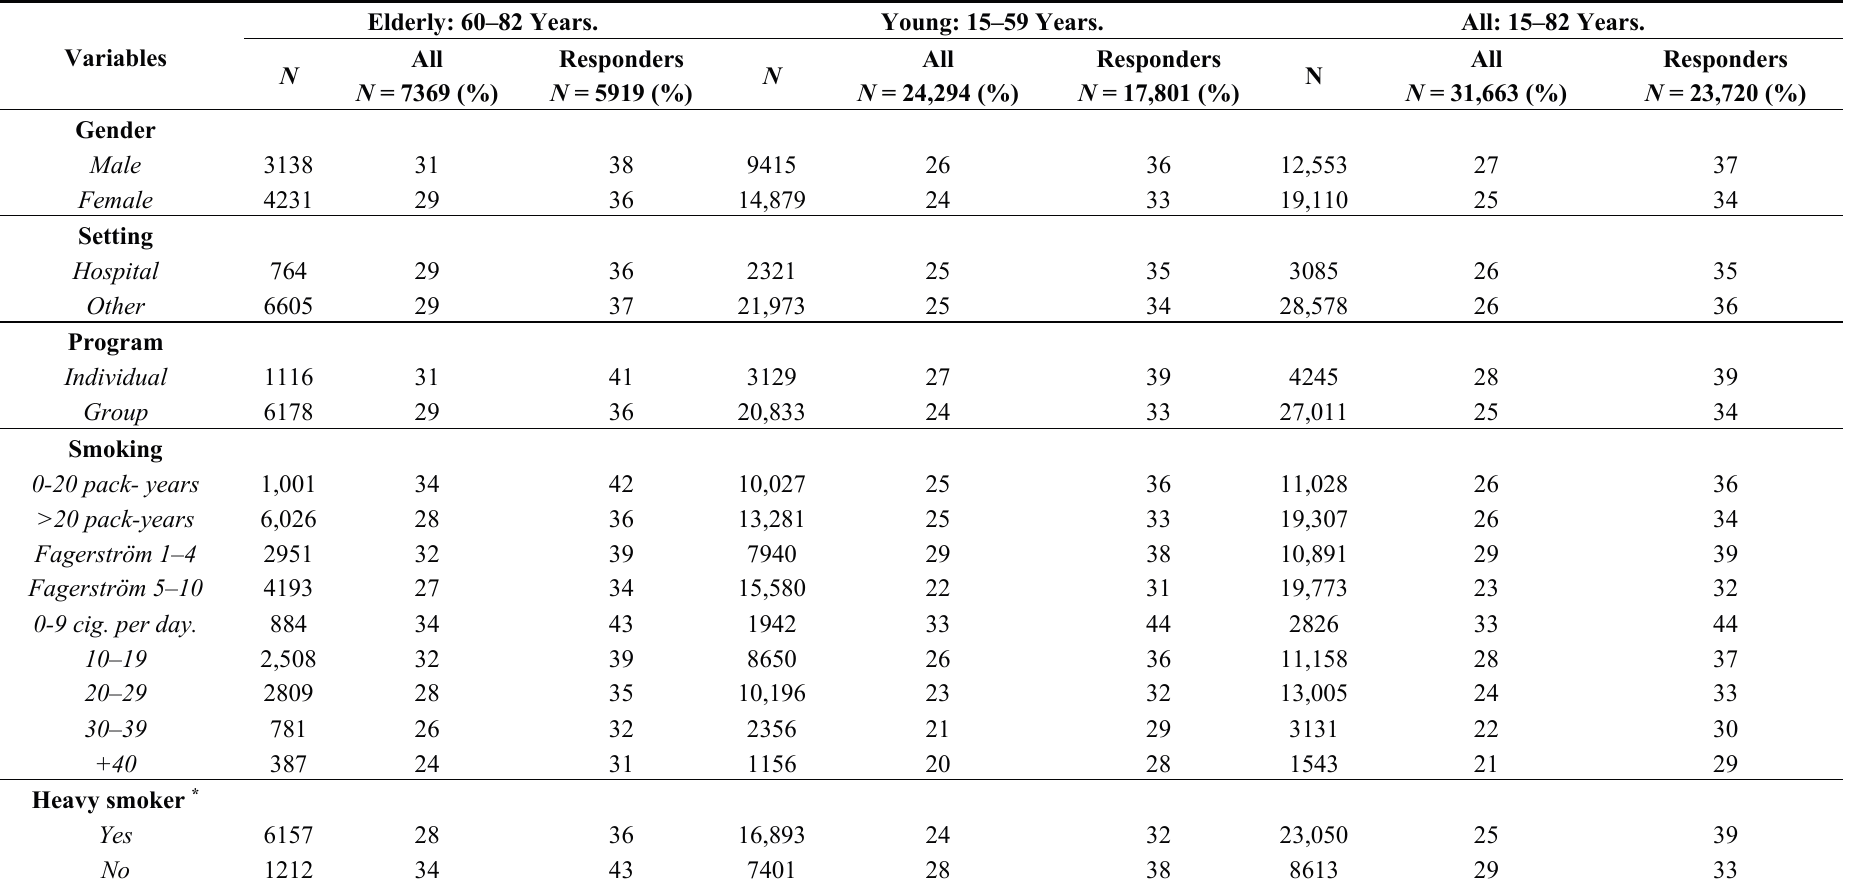
Table 2. Characteristics in numbers ( N ) and six months continuous abstinence rates given in percent (%) for all (including non-responders) and for responders only for both elderly, young and all. Variables